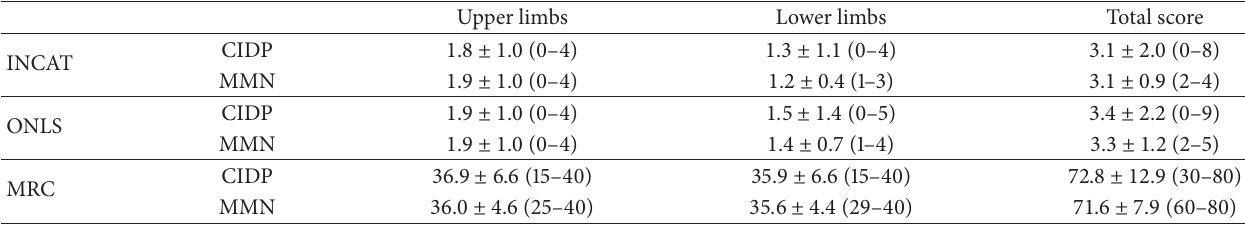
Table 2: INCAT, ONLS, and MRC scores in CIDP and MMN